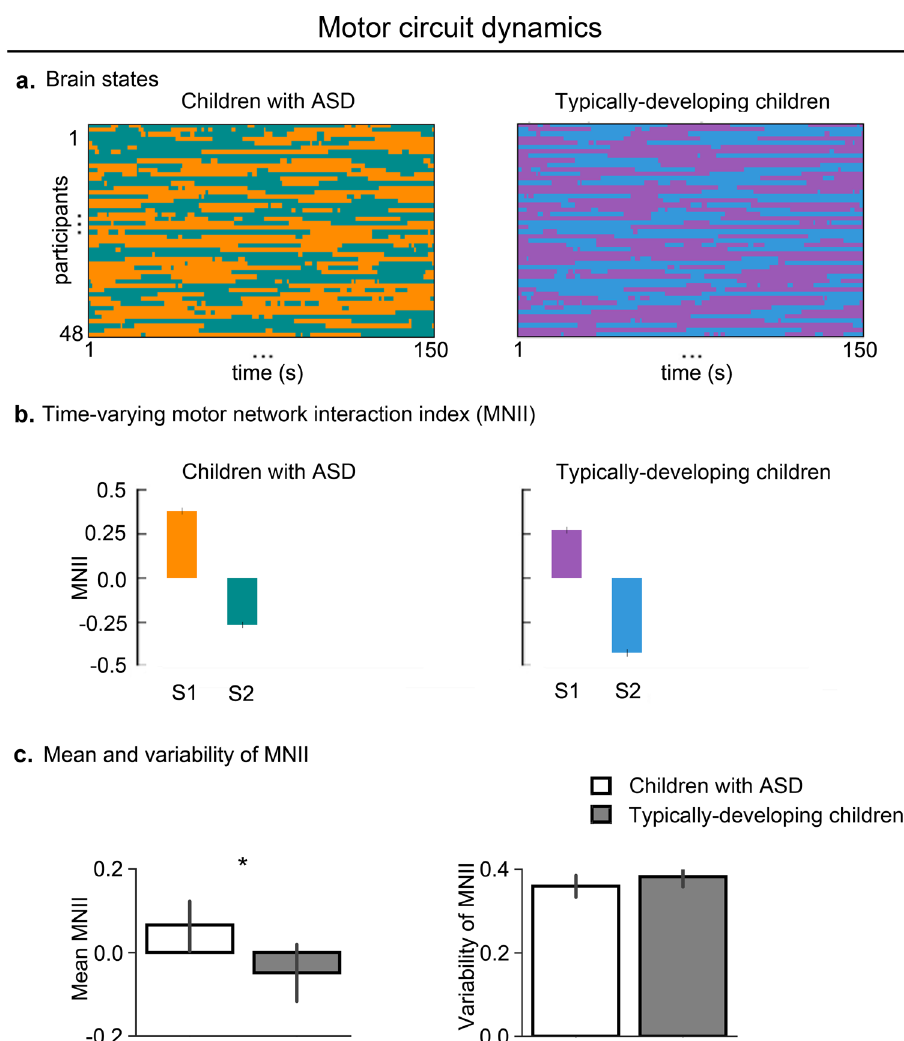
Fig. 3 Aberrant temporal dynamics of motor circuit in children with ASD. a Children with ASD and TD children showed two states. Color codes distinct states in each participant. States 1 and 2 in children with ASD are represented by dark orange and dark cyan, respectively; states 1 and 2 in TD children are represented by moderate violet and bright blue, respectively. b Motor NII (MNII) of dynamic brain states showed intermittently increased cross-network interaction in children with ASD compared to TD children. c The temporal mean of dynamic cross-network interaction in the motor circuit, assessed using mean of dynamic MNIIs across states, was signi fi cantly higher in children with ASD, compared to TD children. The temporal variability of dynamic cross- network interaction in the motor circuit, assessed using standard deviation of dynamic MNIIs across states, did not differ between children with ASD and TD children. Two-sided two sample t -tests were used to compare mean and temporal variability of MNIIs between children with ASD and TD children. Error bar shows standard error of mean. * p <